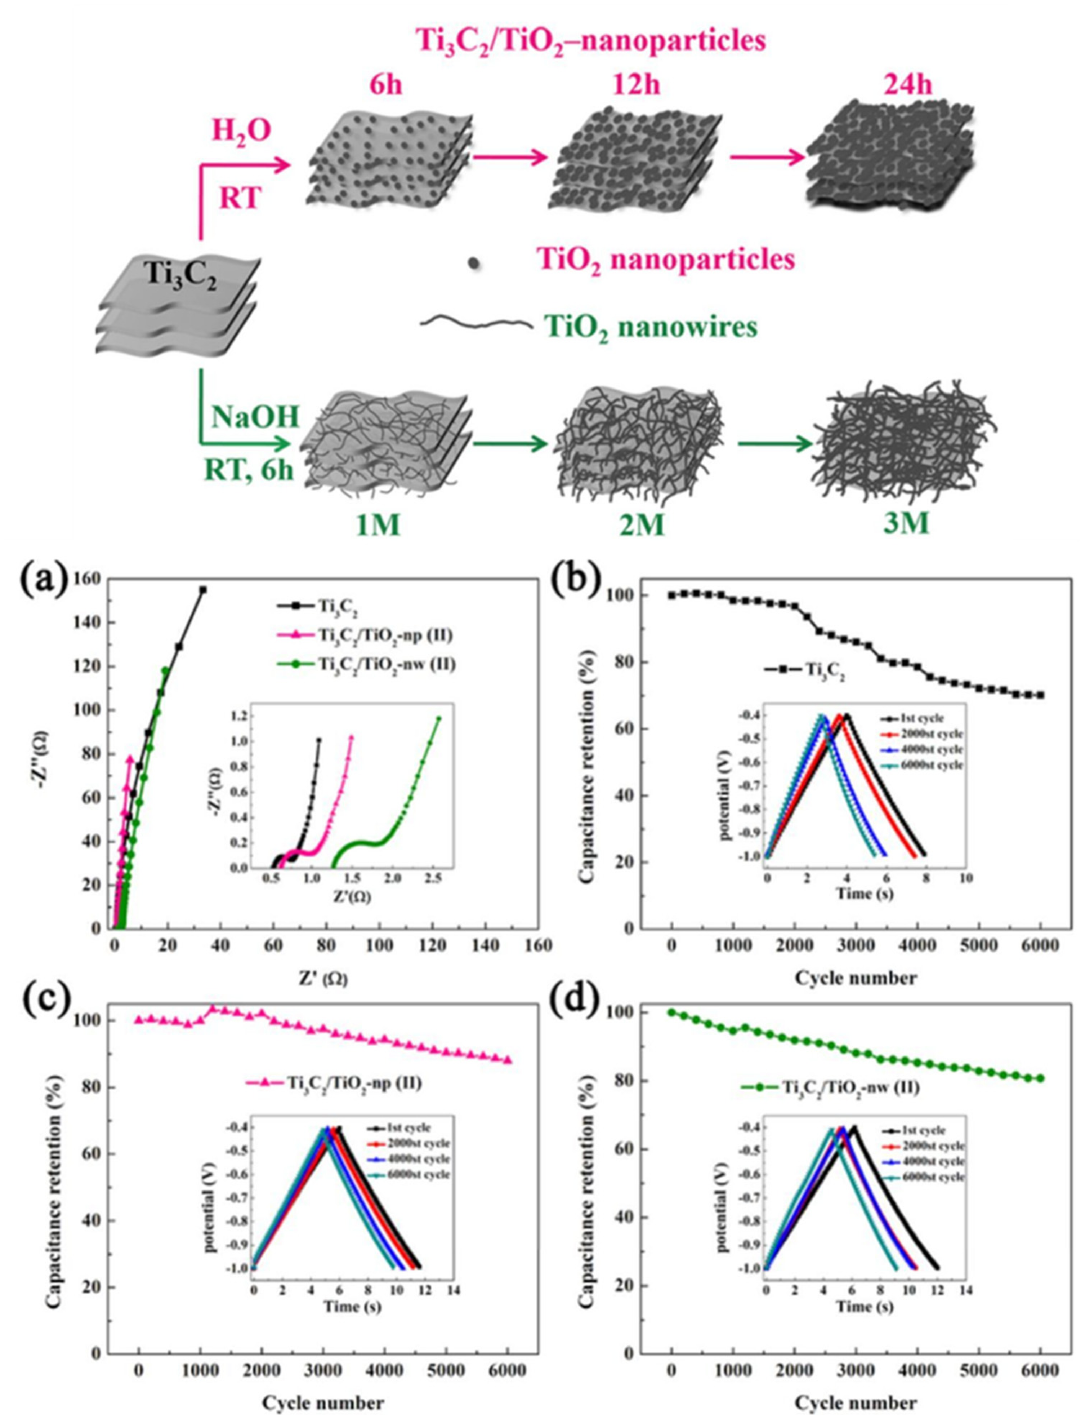
Figure 20. An exemplification of Ti 3 C 2 /TiO 2 composites fabrication, ( a ) EIS, and ( b – d ) cyclability retention of various Ti 3 C 2 /TiO 2 -electrode [147].